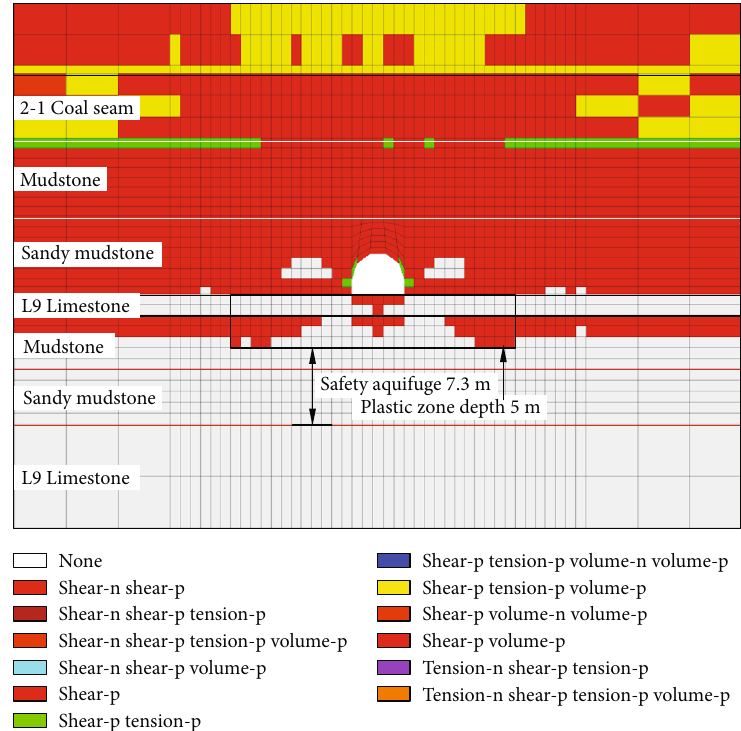
Figure 8: Failure of bottom rock stratum at y = 130 m in the fl oor drainage roadway when roadway internal is 80m.